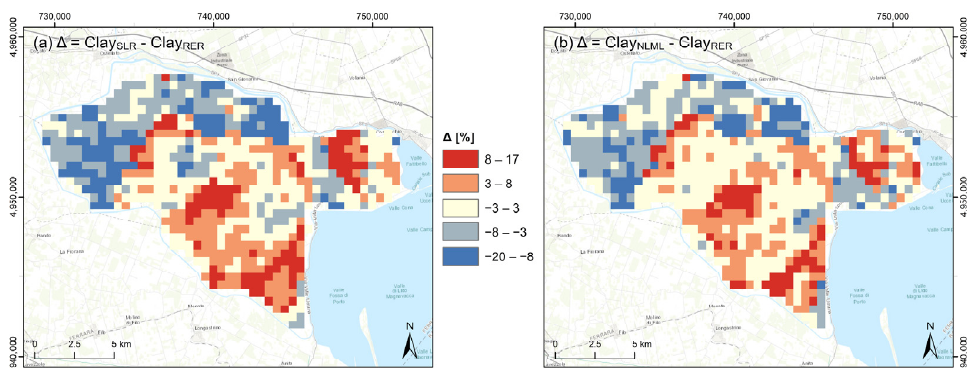
Figure 8. ( a ) Map of the difference between clay values predicted by the SLR model starting from K abundances and clay values reported in the RER soil textural map (Clay SLR –Clay RER ); ( b ) map of the differences between clay values predicted by the NLML model and clay values reported in the RER soil textural map (Clay NLML –Clay RER ). Cartographic reference system: WGS 84, UTM Zone 32N.